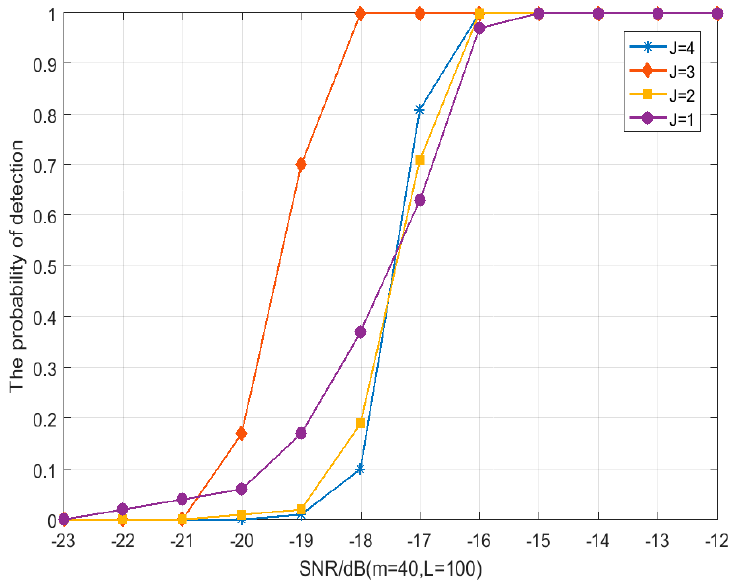
Figure 11. The relation between detection probability and SNR with different J and fixed m and L ( m = 40, L = 100).